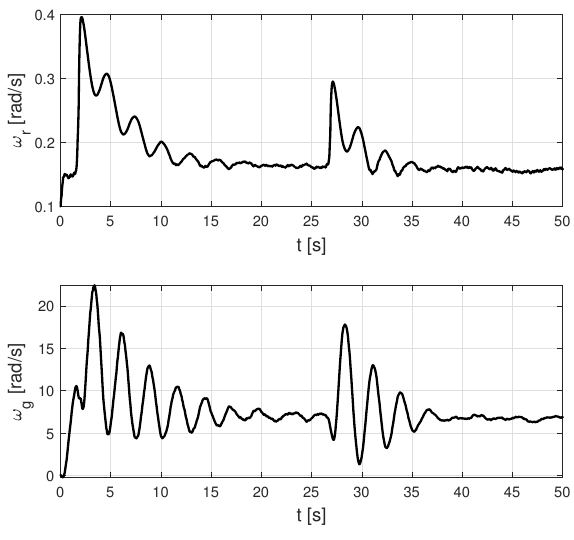
Figure 9. Angular